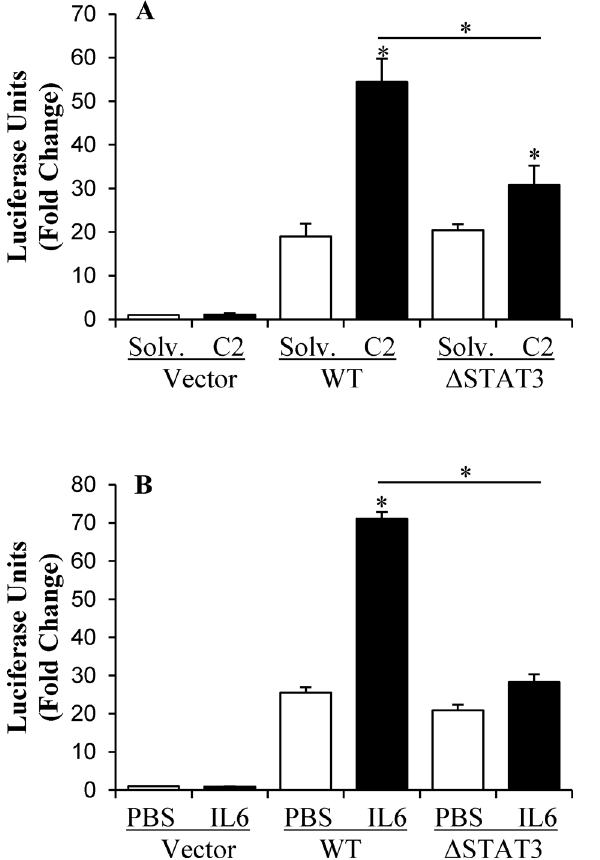
Fig 4. The effect of STAT3 response element mutation on HAMP promoter activation by ceramide. The single STAT3 response element within 0.6kbp HAMP promoter region cloned in pGL3 basic vector was mutated, as described in the experimental procedures. HepG2 cells, transfected with pGL3-basic vector harboring wild-type (WT) or mutated ( Δ STAT3) 0.6 kb HAMP promoter, or empty vector (vector) as negative control, and pRL-SV40 plasmid, as control for transfection efficiency, were treated with ( A ) 60 μ M C2 ceramide (C2) and solvent control (solv.) or ( B ) 40 ng/ ml IL-6 and PBS control for 8 hours. Dual luciferase reporter assays were performed, as described in the experimental procedures. HAMP promoter activity, expressed in relative luciferase units, in treated cells was calculated as fold change of that in control cells transfected with empty vector-and treated with solvent. Asterisks indicate statistical significance (P <